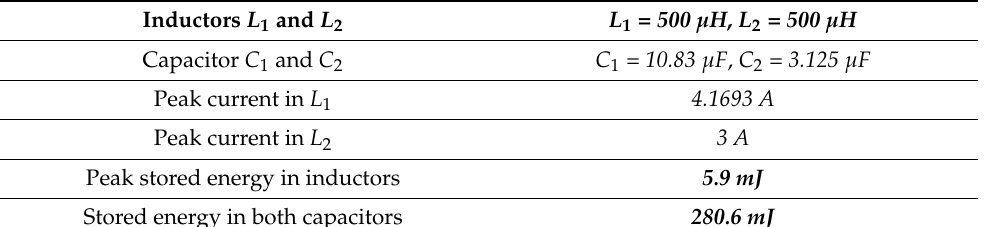
Table 2. Super-boost converter design.